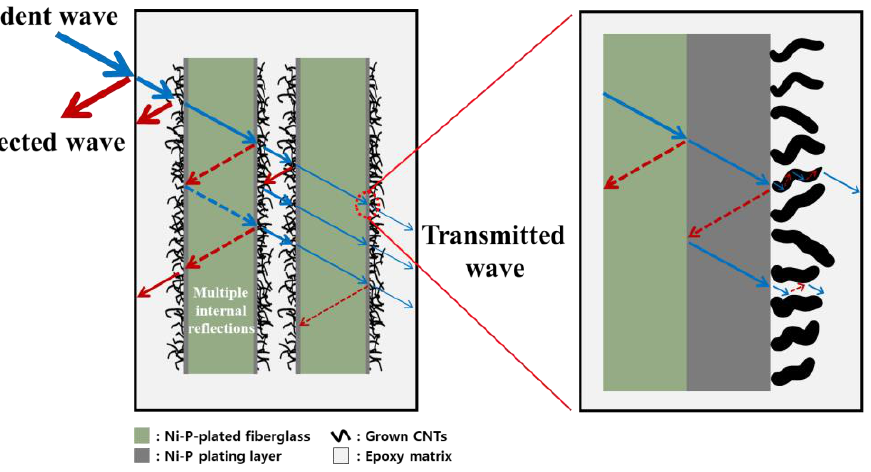
Figure 9. Schematic of the EMI shielding behavior of HNGF-CNTs/epoxy composites.